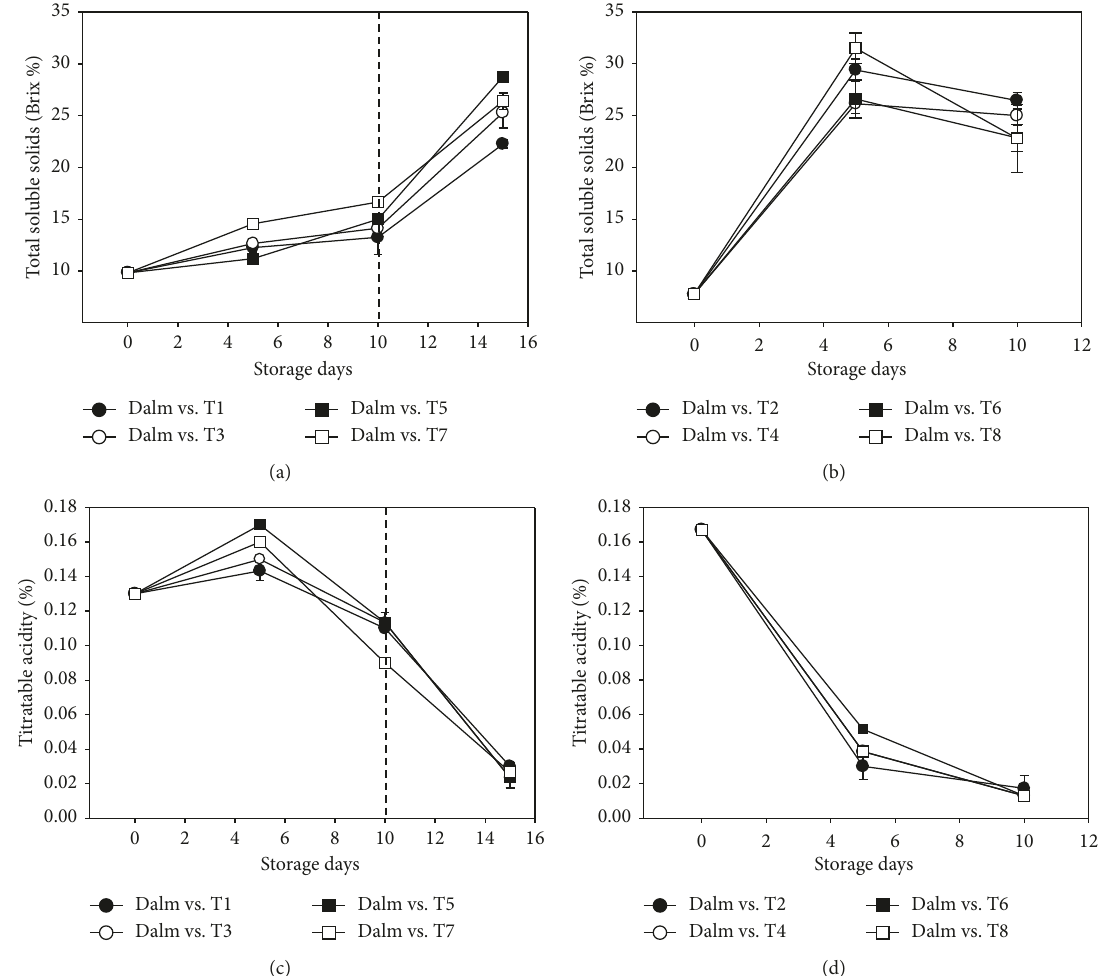
Figure 2: Stenospermocarpic mango “Ataulfo” fruit coated with different treatments: T1 and T2 (coating of banana “Pear”), T3 and T4 (coating of soursop), T5 and T6 (stenospermocarpic mango “Ataulfo”), and T7 and T8 (control fruit: uncoated). (a and c) Mango fruit stored at 10 80% (the dotted line indicates the transference at 22 and then stored at 22 2 ° C, HR > ±